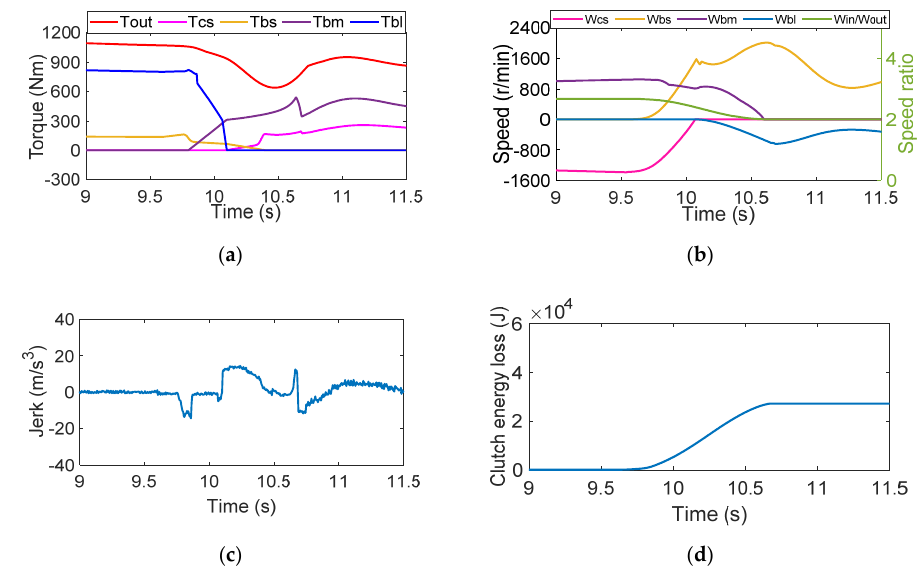
Figure 7. Simulation results of 2–3 power-on double-transition upshift for Strategy 3. ( a ) Output shaft and clutch torque. ( b ) Clutch speed and speed ratio. ( c ) The jerk of shift process. ( d ) The clutch energy loss of shift process.